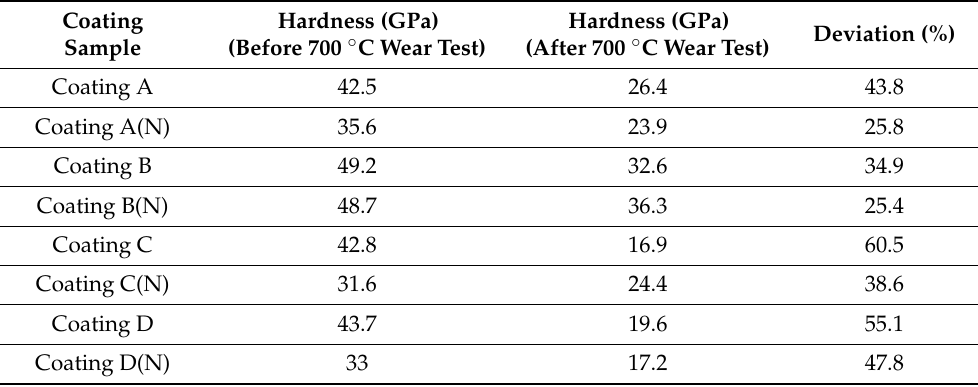
Table 5. Hardness comparison of the coatings before and after 700 ◦ C